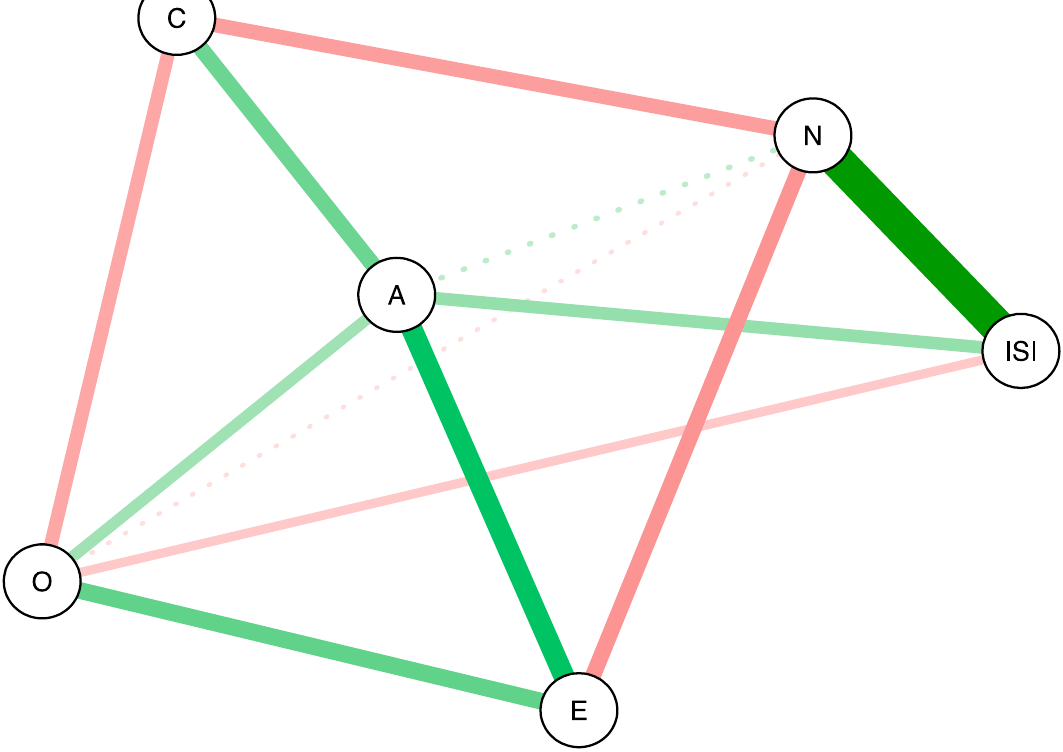
Figure 1. Concentration network of personality traits and the Insomnia Severity Index (ISI) sum score. Green lines indicate positive partial correlations; red lines indicate negative partial correlations. Solid lines indicate shortest paths, the other partial correlations are shown as dashed lines. The color saturation, thickness, and length of the edges represent the strength of the association. Abbreviations: A = agreeableness, C = conscientiousness, E = extraversion, N = neuroticism, O = openness. Neuroticism, agreeableness, and openness show direct relations to ISI, while conscientiousness and extraversion are indirectly related to ISI. The partial correlation between neuroticism and ISI is stronger than any of the other associations.